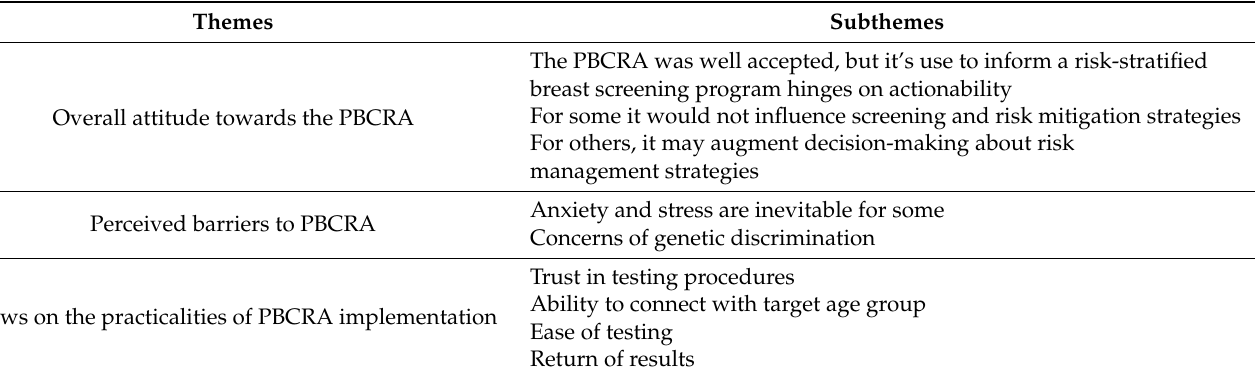
Table 2. Summary of themes and